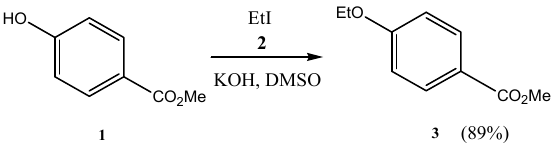
Figure 4. Water-uptake of the silica gel after thermal treatment at 600 °C.